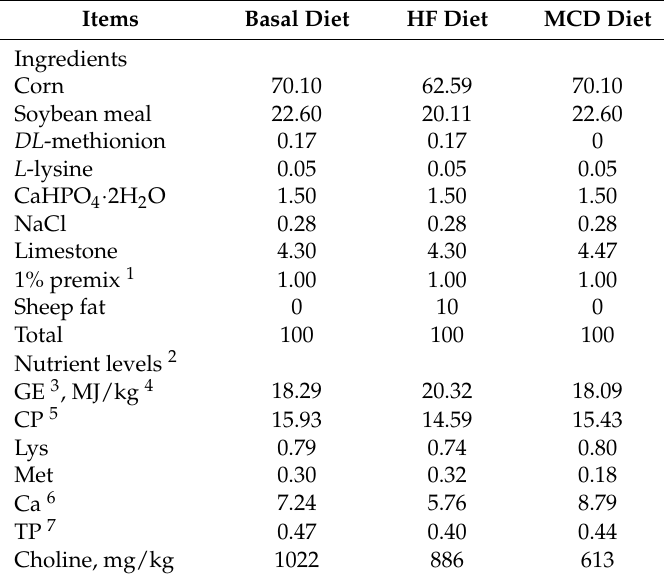
Table 1. Composition and nutrient levels of the diets (air-dry basis) %.